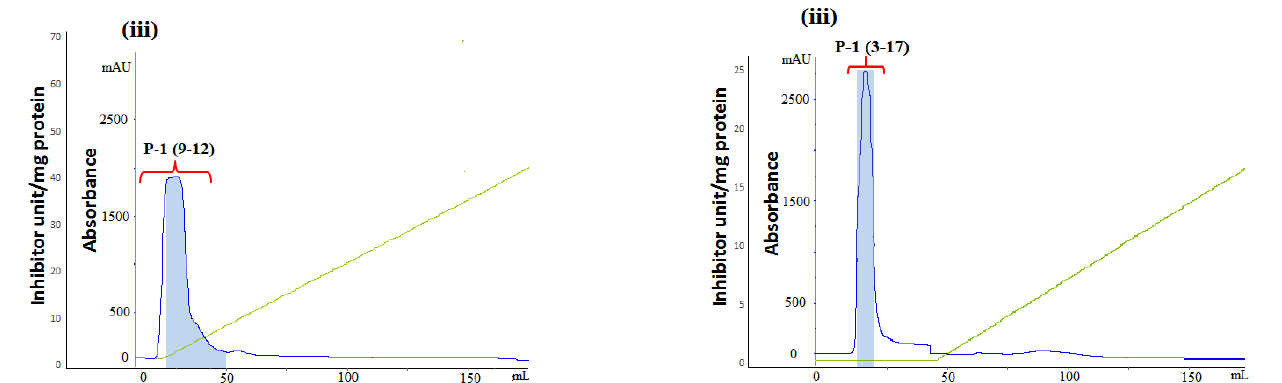
Figure 2. FPLC elution profiles of PIs from canola meal extracts of ( A ) BLN-3447 and ( B ) Rivette. Numbers in the bracket at the top of each peak represent fraction numbers obtained in respective peaks. ( A i ) 80% ammonium sulfate fraction separated by ion-exchange chromatography, showing active protease inhibitor (PI) peak, P-3. ( A ii ) Concentrated ion- exchange peak P-3 separated on gel filtration column showing active PI peak, P-2. ( A iii ) Concentrated active peak P-2 from gel filtration column separated on ion-exchange column, showing the active peak, P1. ( B i ) 80% ammonium sulfate fraction separated by ion-exchange chromatography, showing active PI peak, P-1. ( B ii ) Concentrated ion-exchange peak P-1 separated on gel filtration column showing an active PI peak, P-2. ( B iii ) Concentrated active peak P-2 from gel filtration column separated on the ion-exchange column, showing the active peak, P-1.